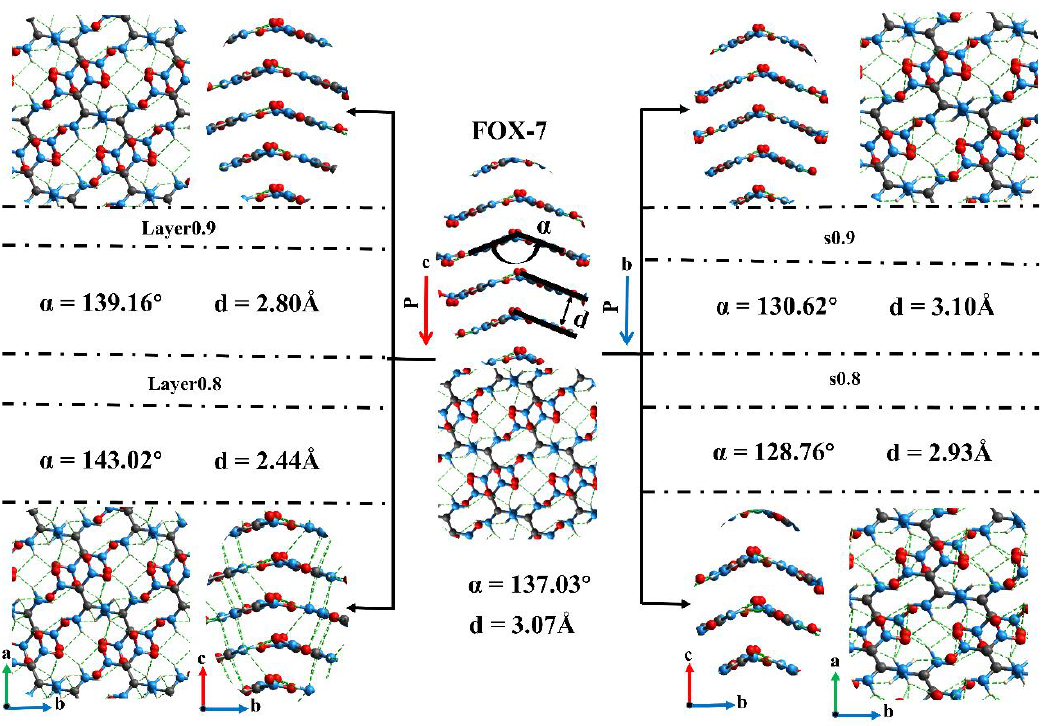
Figure 3. The details of structures in five cases. The left and right cases are compression along the c and b directions, respectively. The green dotted lines represent intermolecular hydrogen bonds.